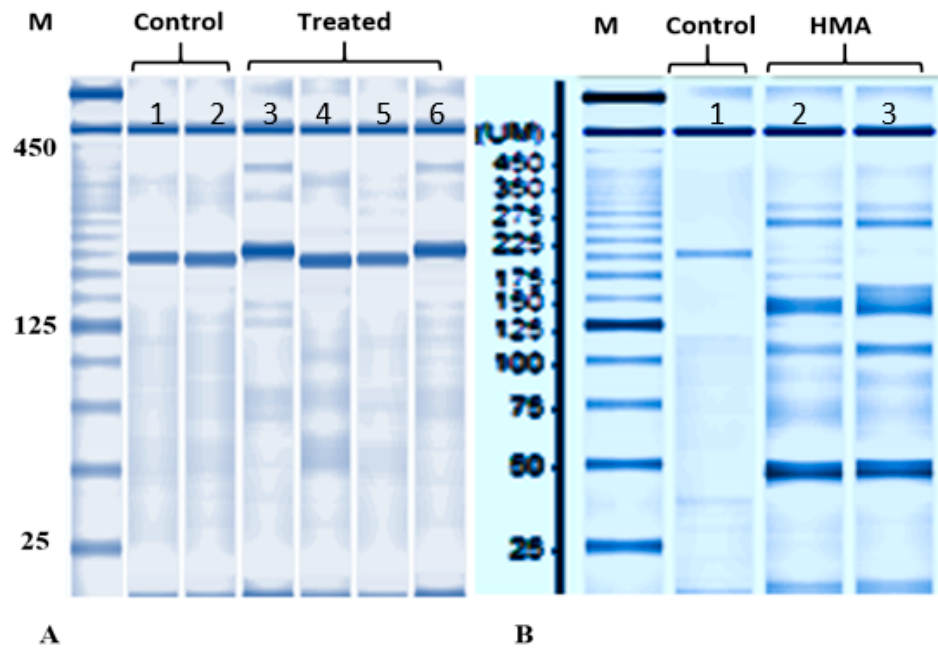
Figure 3. Genotyping by HMA assay in the un-injected and injected sterlet embryos. PCR products encompassing sgRNAs target sites were analyzed using a microchip electrophoresis system. ( A ) Bands from DNA of two injected embryos (sample number 3 and 6) were found to have different size; ( B ) HMA of two embryos having different bands (sample number 2 and 3). The sample 2 and 3 in Figure 3B were numbered as 3 and 6 in Figure 3A. Heteroduplex bands and multiple short bands are shown in sgRNA+Cas9 RNP injected embryos (crispants; B: sample 2 and 3).